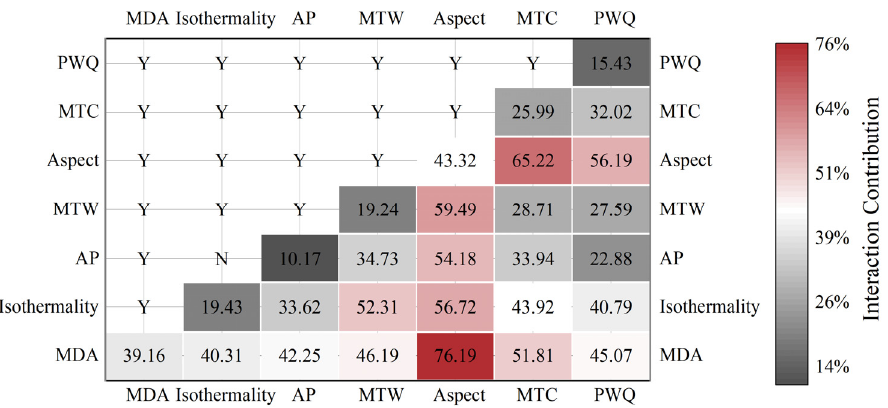
Figure 9. Thermodynamic diagram of driving force interaction. Note: nonlinear enhance: (q(x1 ∩ x2) > q(x1) + q(x2); bi-nonlinear enhance: q(x1 ∩ x2) > Max(q(x1), q(x2)). Y indicates that there is a significant difference between the two factors on the vegetation habitat at the 95% confidence level, and N indicates that it is not significant.